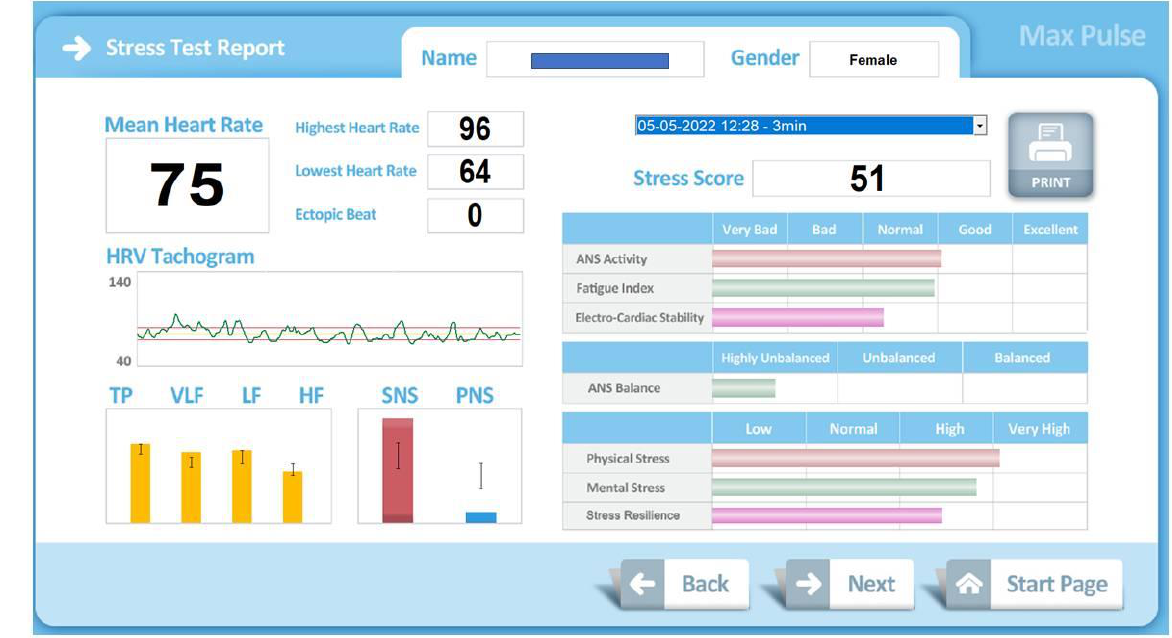
Figure 3. Graphic information provided by Max Pulse ® .